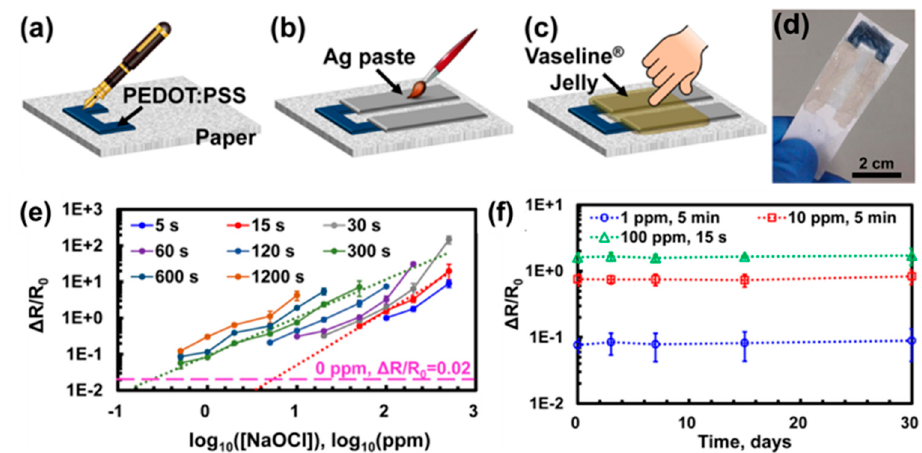
Figure 9. Schematic diagram of fabrication methods for paper-based free chlorine sensor strip based on PEDOT/PSS. ( a ) First, drawing of film as sensing active layer by using a pen filled with PEDOT/PSS solution; ( b ) second, drawing of electrodes with silver paste; ( c ) protecting the Ag electrodes from water with petroleum jelly; ( d ) photograph of manually prepared sensor kit; ( e ) sensing responses with different free-chlorine concentrations; ( f ) Storage stability. Reprinted with permission from [75]. Copyright 2016, American Chemical Society.